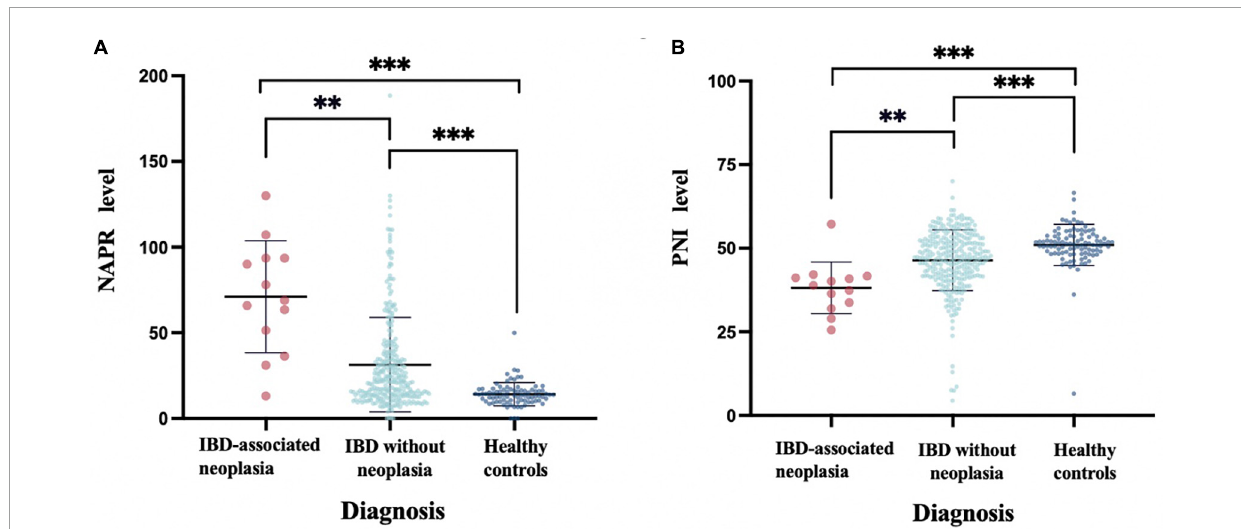
FIGURE6 Peripheral blood NPAR levels (A) and PNI levels (B) in patients with IBD-associated Neoplasia (Dysplasia or CRC) vs. IBD without Neoplasia vs. healthy controls (HC). Boxplots represent median and interquartile ranges for serum NPAR or PNI within each sub cohort, ∗∗ P < 0.01, ∗∗∗ P <